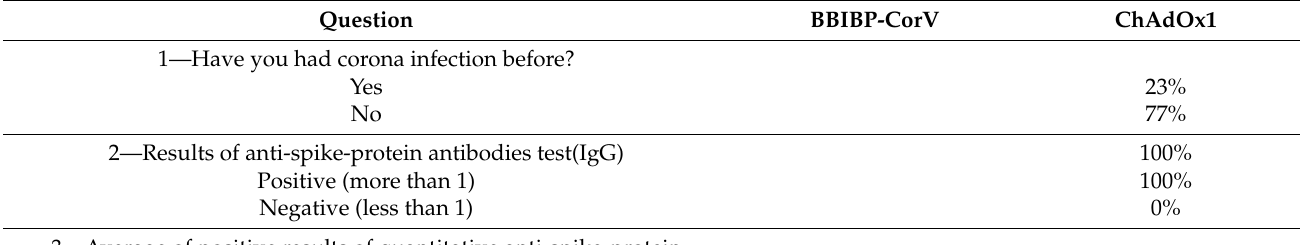
Table 4. Results of IgG anti-spike-protein antibodies test and laboratory tests after vaccination with BBIBP-CorV or ChAdOx1